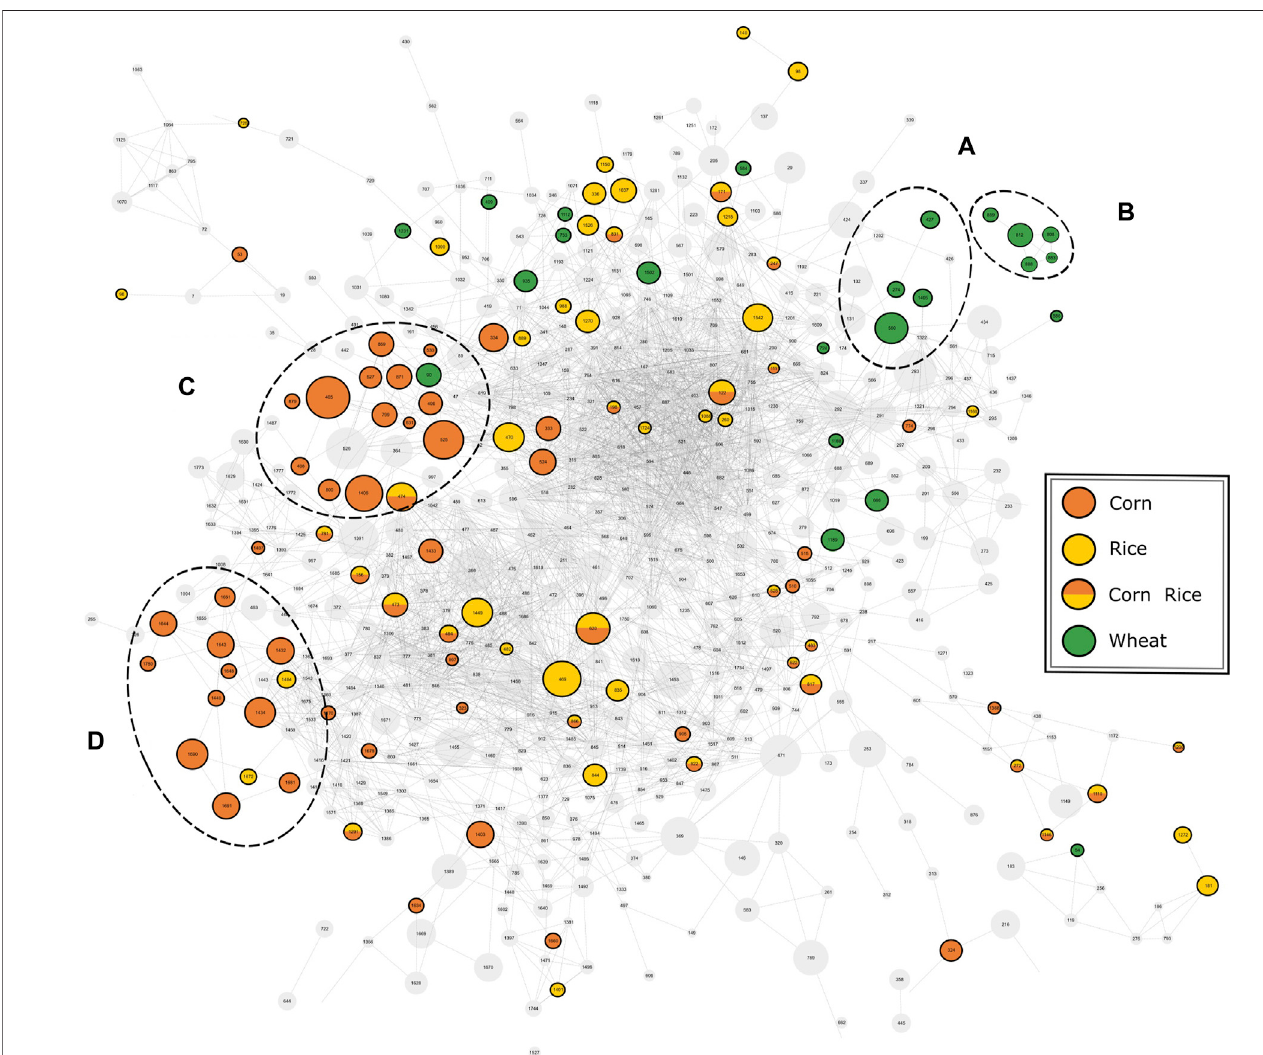
FIGURE 4 | Mass spectral similarity network of the fragmentation spectra of compounds detected by UPLC-ToF-MS. The nodes representing the respective compounds are connected by edges representing their spectral similarity. Compounds found to be speci fi c for a carbohydrate source are colored accordingly. Two cluster of potential marker are highlighted for wheat (A, B) and corn (C, D)